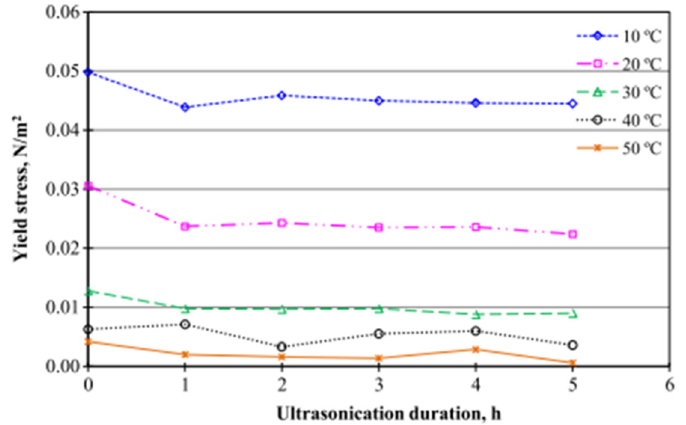
Figure 11. Effect of ultrasonication duration on the yield stress of the Al 2 O 3 -water NF. Adapted from [168].